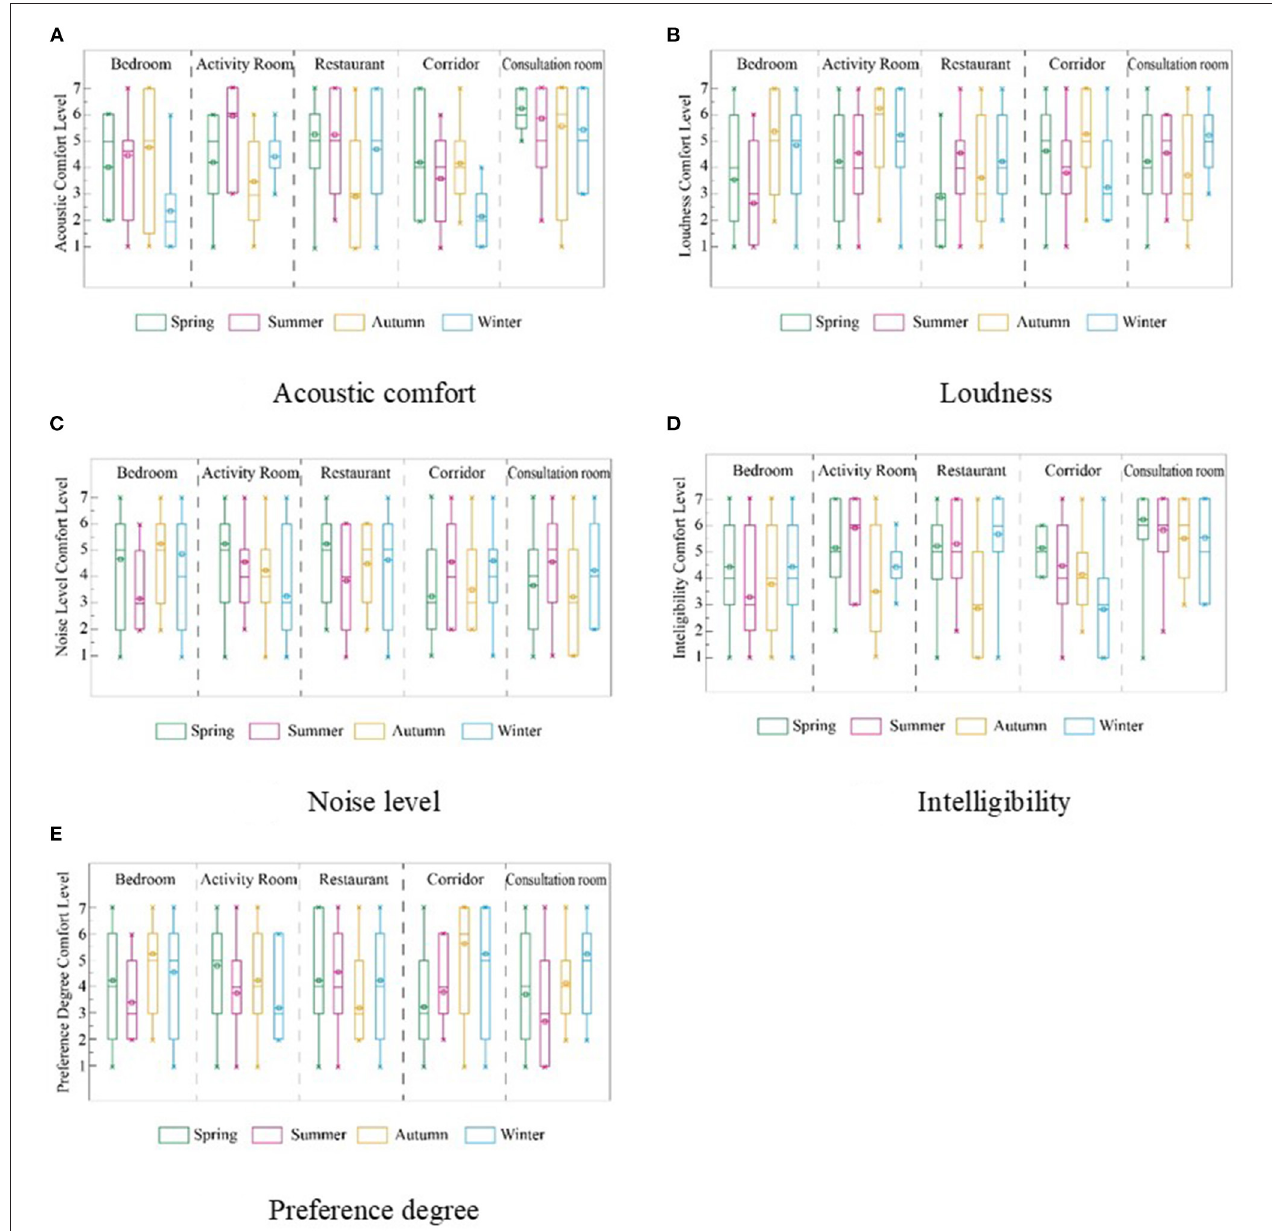
FIGURE 3 | Evaluation of acoustic indicators of 4 RECFs based on seasonal differences. (A) Acoustic comfort, (B) Loudness, (C) Noise level, (D) Intelligibility, and (E) Preference